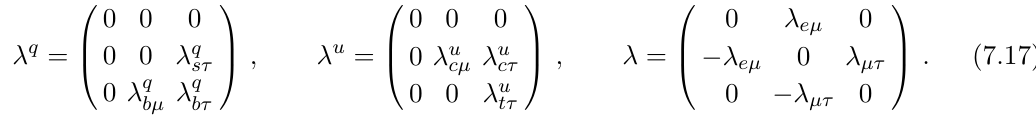
data at 1 σ . For both plot µ